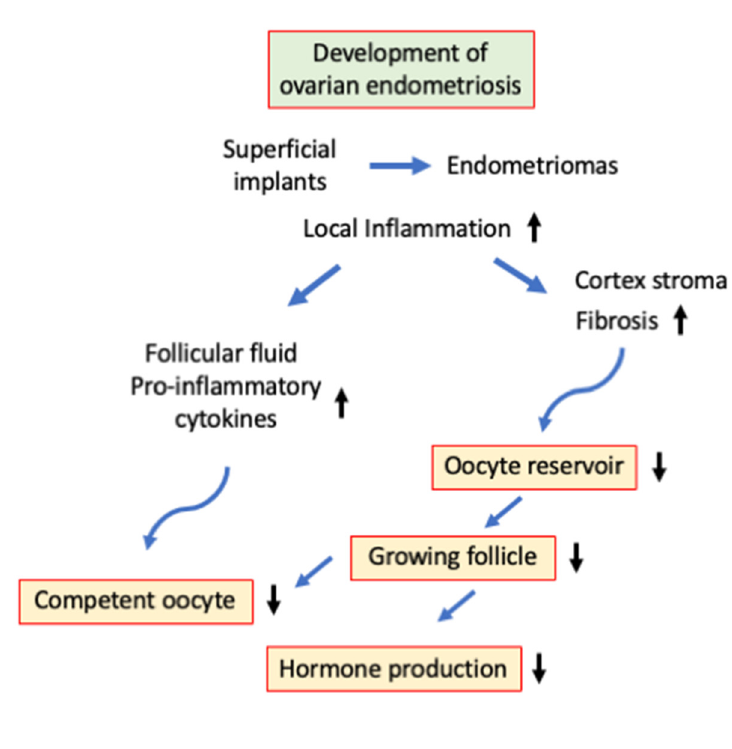
Figure 2. Schematic mechanism of ovarian dysfunctions in women with endometriosis.